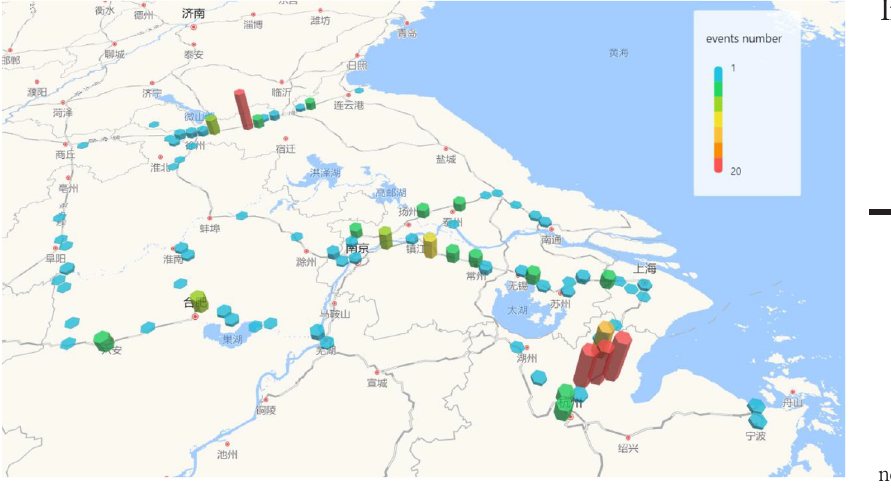
Figure 2. A heat map of bird